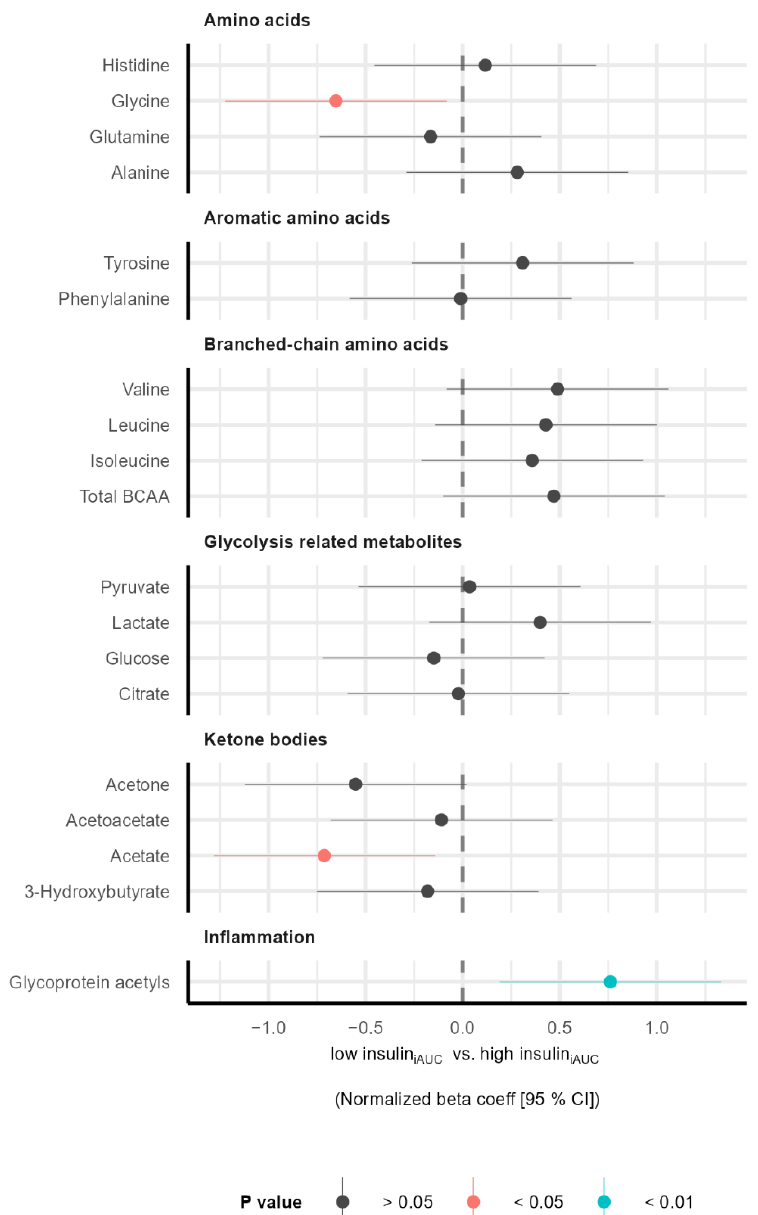
Figure 2. Amino acids, glycolysis-related metabolites, ketone bodies, and inflammation markers concentration in plasma before intervention. The forest plot displays the normalized beta coefficients (mean difference) and 95% confidence interval for the difference between the low insulin iAUC and high insulin iAUC groups. Estimates on the left and right side of the zero-line translate to lower and higher in the high insulin iAUC group compared to the low insulin iAUC group, respectively. Color denotes the p value. Abbreviations: BCAA: Branched-chain amino acids, iAUC: incremental Area Under the Curve.